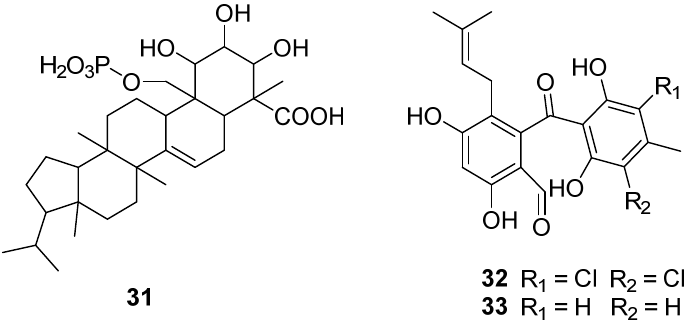
Figure 9. Structure of triterpene 31 and polyketides 32 and 33 [47,48]. SB87-Cl ( 32 ) and SB87-H ( 33 ) (Figure 9) [48] were isolated from Chrysosporium